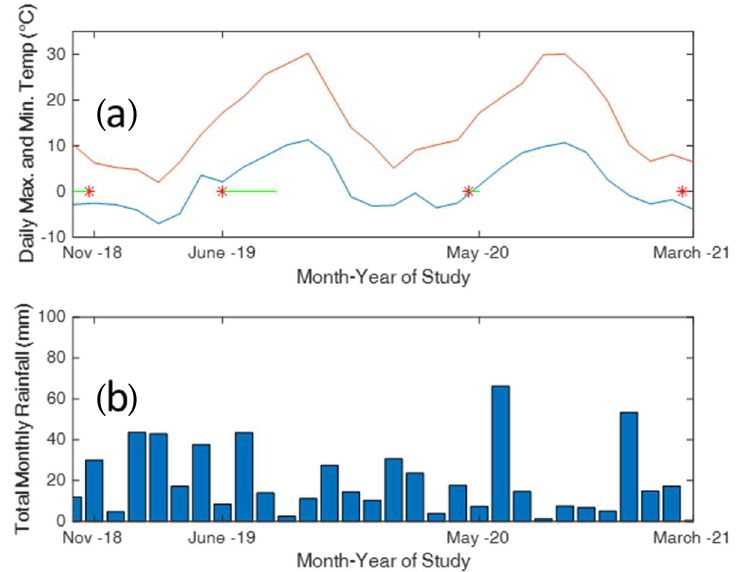
Figure 2. Maximum and minimum temperature and total monthly rainfall for the Central Oregon Agriculture Research and Extension Center during the study. Red stars indicate when samples were scanned, and green lines indicate when samples were in storage awaiting return to the site. ( a ) mean monthly daily maximum and minimum temperature, ( b ) total monthly rainfall for the site.